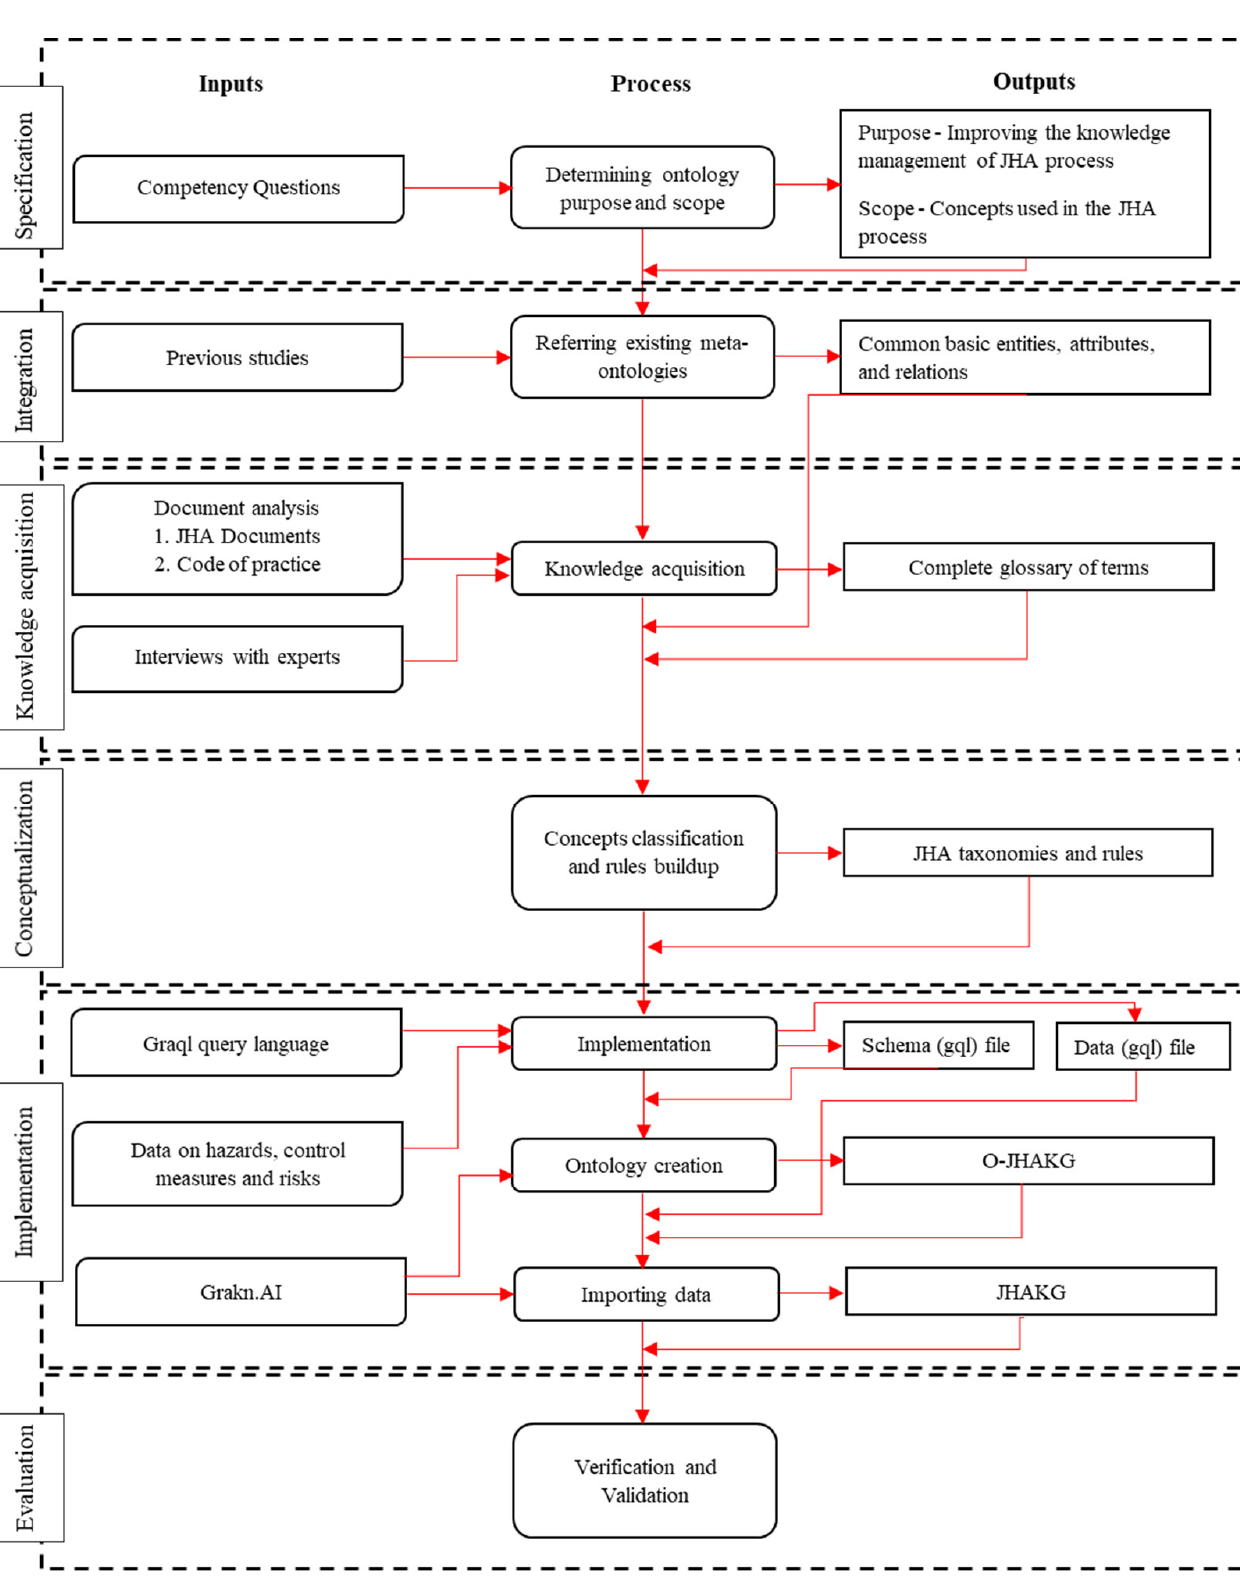
Figure 1. Development process of JHAKG.